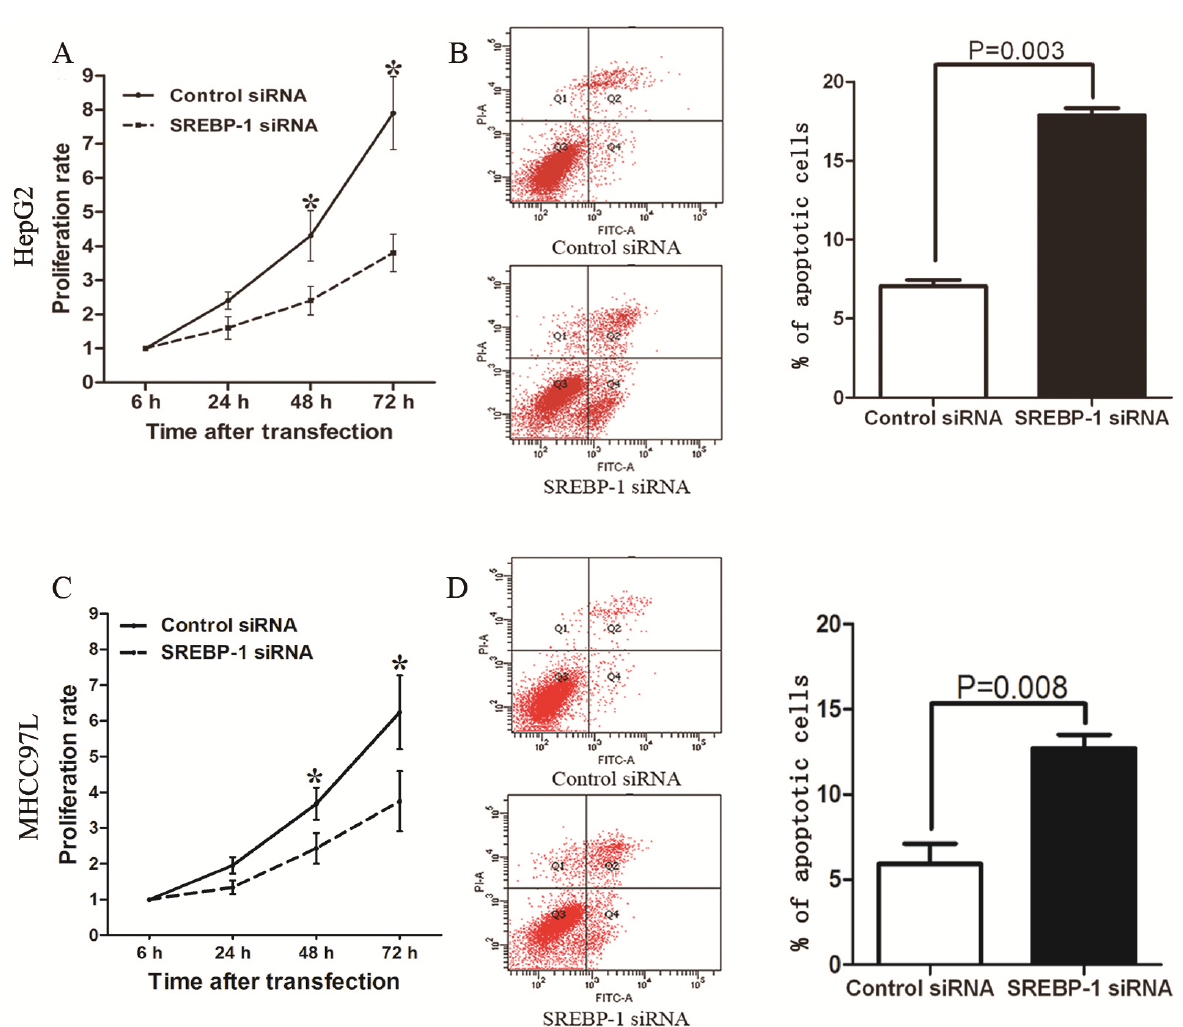
Figure 4. SREBP-1 regulates proliferation and apoptosis in HepG2 and MHCC97L cells. MTT assays showed that SREBP-1 knockdown reduced the viability of ( A ) HepG2